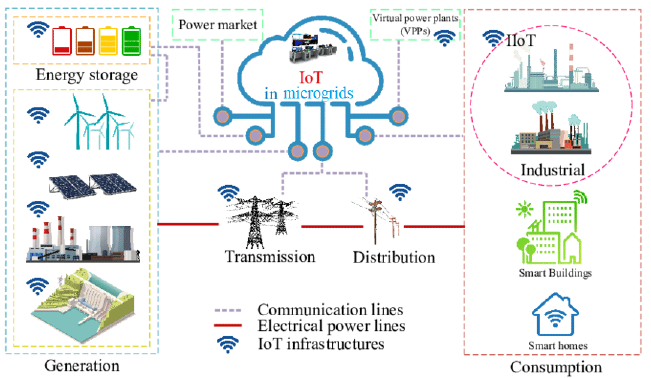
Figure 1. Schematic diagram of IoT-based